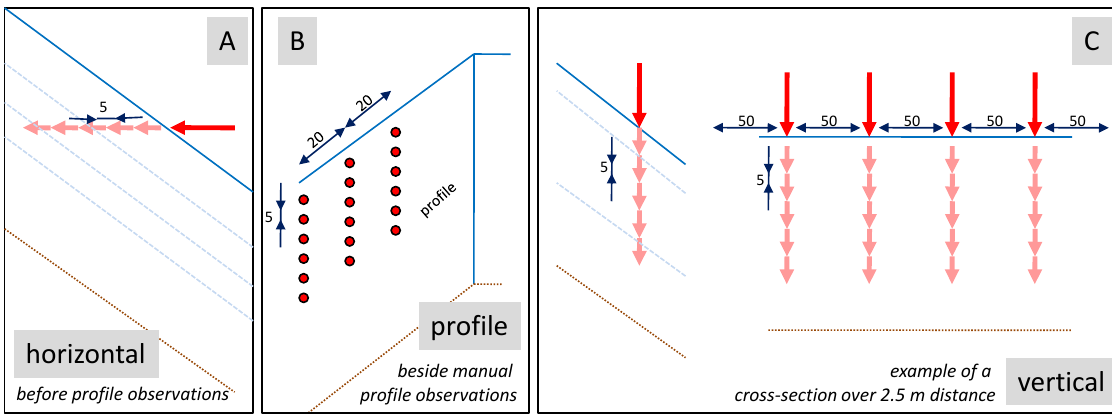
Fig. 4. Liquid water content measurements: sampling design for horizontal, profile and vertical measurements. A) horizontal measurements in 5 cm steps to a depth of 75 cm. B) observations adjacent to manual snow profile, vertical distance 5 cm, slope-parallel distance 20 cm. C) vertical measurements for spatial variability observations, measurement steps 5 cm, horizontal distance 50 cm. Refer also to Tab. 2 for extent and spacing of measurements.